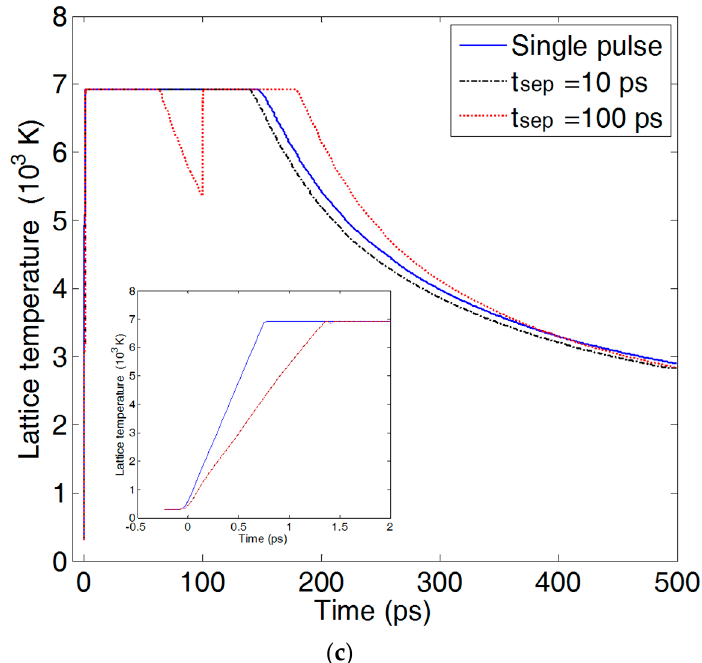
Figure 2. Time dependence of calculated ( a ) optical reflectivity, ( b ) electron temperature and ( c ) lattice temperature on the copper surface for different laser pulses with the same total laser fluence of 4.0 J/cm 2 .